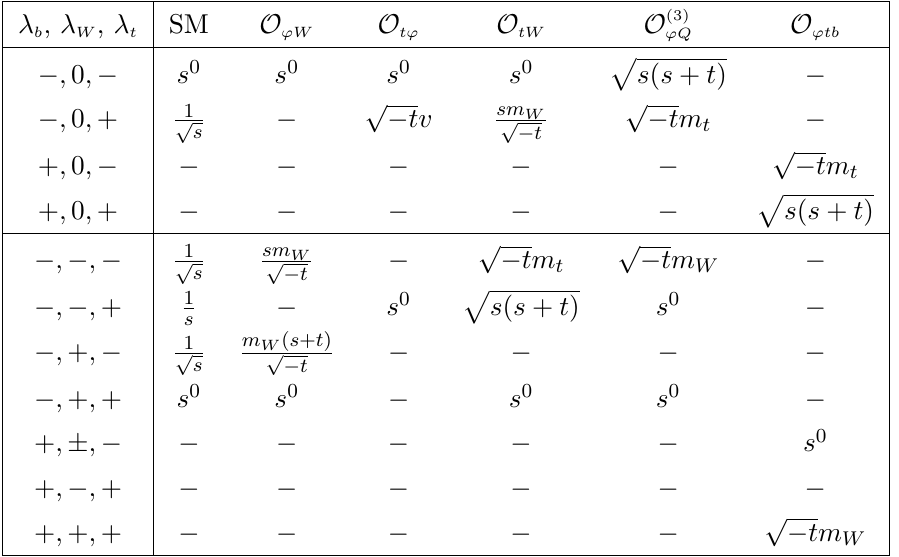
Table 12. Helicity amplitudes in the high-energy limit ( s Overall multiplicative factors are dropped and only the schematic energy dependence is retained for the SM contribution. Helicity entries marked by ‘ section 4.2.1 for a discussion of the